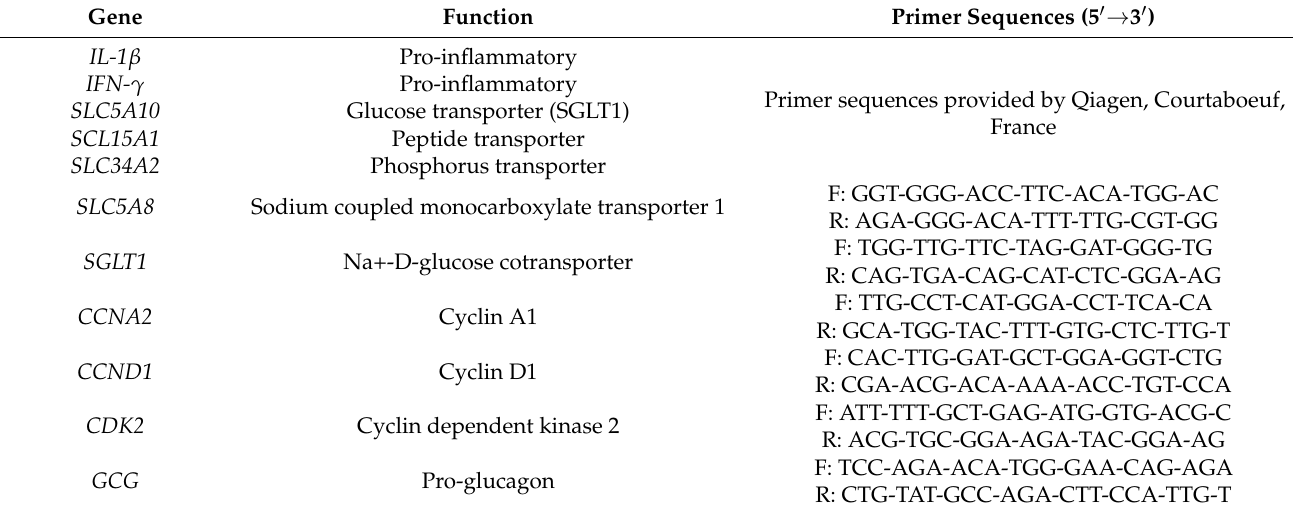
Table 4. Target genes, functions, and primer sequences used for qPCR in ileum samples. Function Primer Sequences (5 (cid:48) → 3 (cid:48)